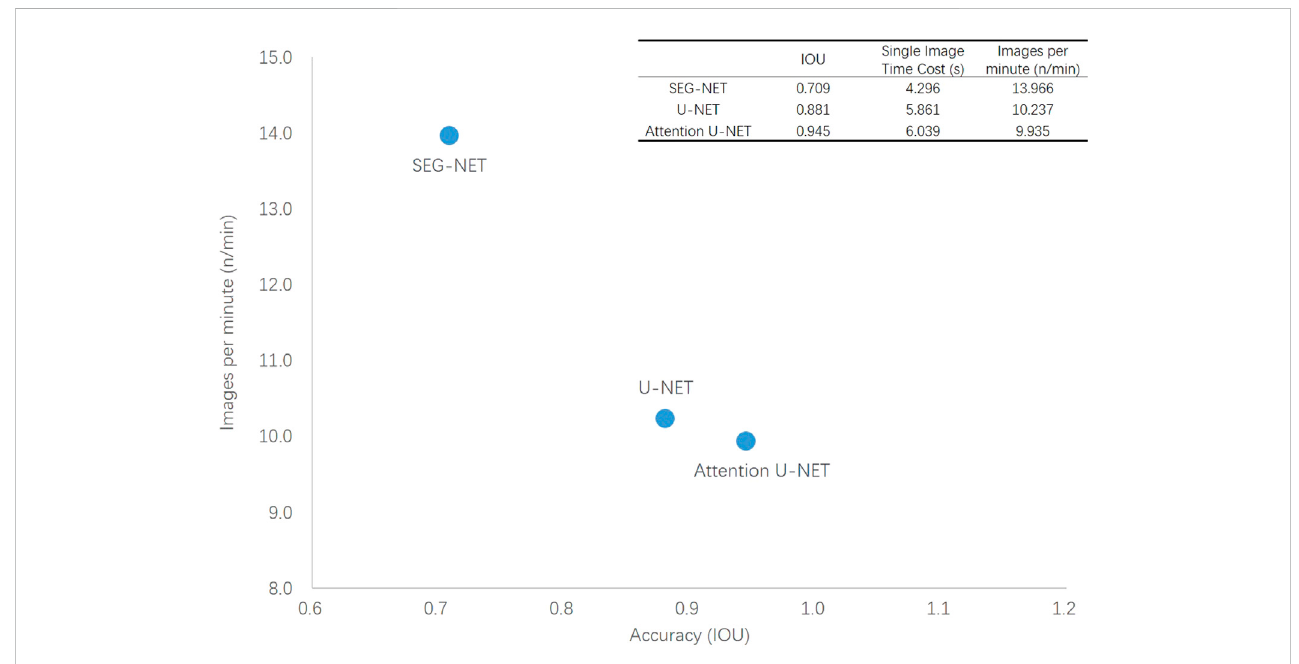
FIGURE 4 Comparison of productivity and accuracy of three deep learning models.